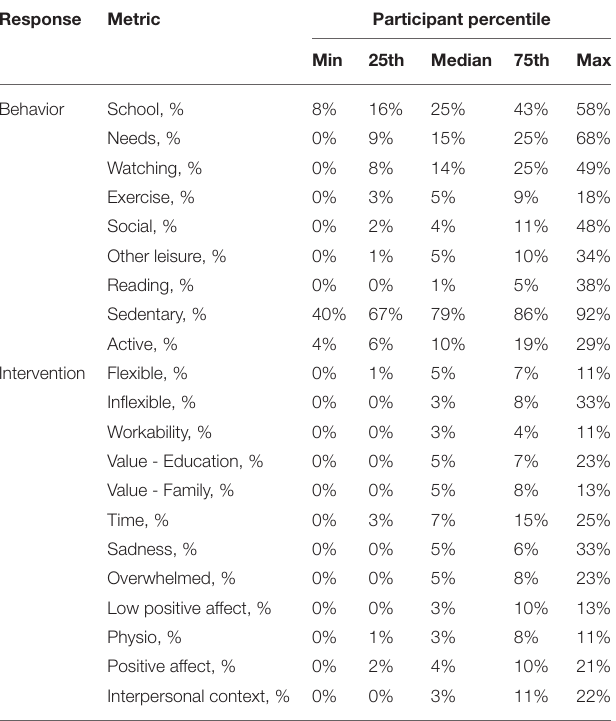
TABLE 4 | Distribution of percent responses with a given code across participants in FGCS